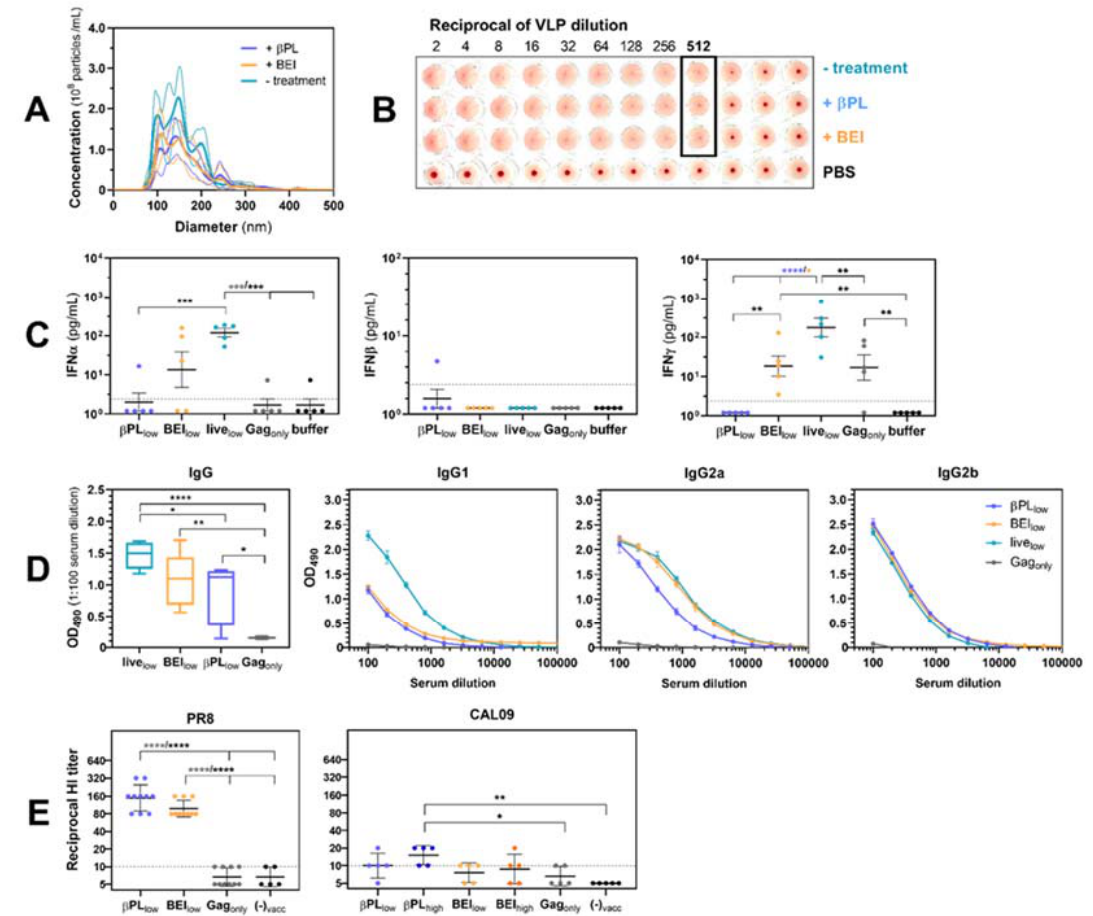
Figure 2. E ff ect of baculovirus inactivation on influenza VLP vaccine immunogenicity. ( A ) Preservation of the particulate integrity and ( B ) HA activity of the VLP formulations after treatment with 16 mM β PL or 5 mM BEI for 16h and 36h at 37 ◦ C respectively was verified by dynamic light scattering analysis and hemagglutination assay, respectively. Broad and narrow lines in panel (A) give the mean and SD of the measured particle concentrations, respectively. ( C ) Abolishment of vaccine vector-induced local innate immune activation reflected by IFN α , IFN β and IFN γ expression was evaluated six hours post-IP-immunization with the respective VLP preparations or bu ff er in peritoneal washes of mice ( n = 5 per group). Data represent log-transformed results for individual animals and group means ± SEM. ( D ) The e ff ect of baculovirus (BV)inactivation on the magnitude and quality of the PR8 HA-specific humoral response was assessed in mouse serum samples taken three weeks post-immunization. Total IgG titers were determined from individual sera ( n = 5 per group), IgG1, IgG2a, and IgG2b isotype levels were determined in pooled sera in duplicates. ( E ) HI antibodies against the vaccine-matched influenza PR8 or the non-matched CAL09 challenge strain were assessed in pre-challenge sera ( n = 4–10). Color code vaccine groups: β PL low (light blue), β PL high (dark blue), BEI low (light orange), BEI high (dark orange), live low (turquoise), Gag only (grey), Non-vaccinated (black). Symbols represent HI titers of individual mice, lines and error bars indicate the group geometric mean titer and SD. Dashed lines indicate the lower limit of detection (LLOD) at a HI titer of 1:10. Statistical significance of di ff erences in mean IFN titers, IgG titers, and HI titers (log-transformed data) were analyzed by One-Way ANOVA and a Tukey correction factor with * p adj < 0.05, ** p adj < 0.01, *** p adj < 0.001, and **** p adj < 0.0001.